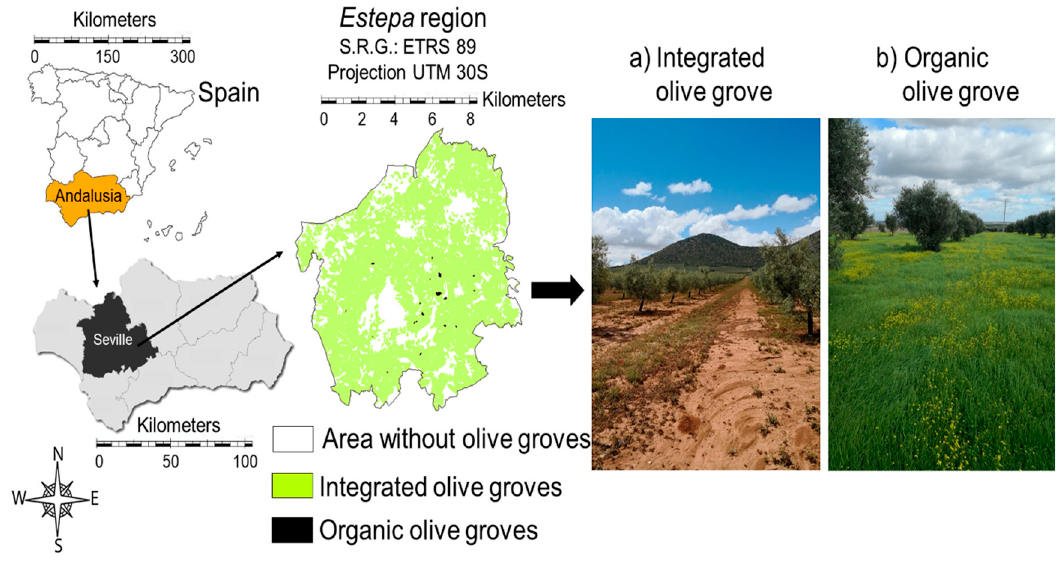
Figure 1. The geographical location of the PDO Estepa. Areas without olive groves, with integrated olive groves ( a ) and with organic olive groves ( b ) and images of the two types of management are shown.